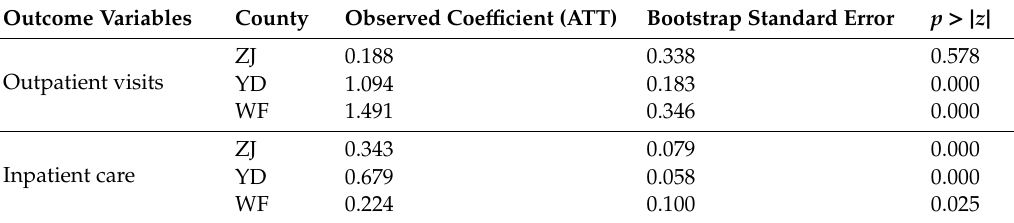
Table 5. Propensity score matching results on average treatment e ff ect (ATT) in TB health care utilization by